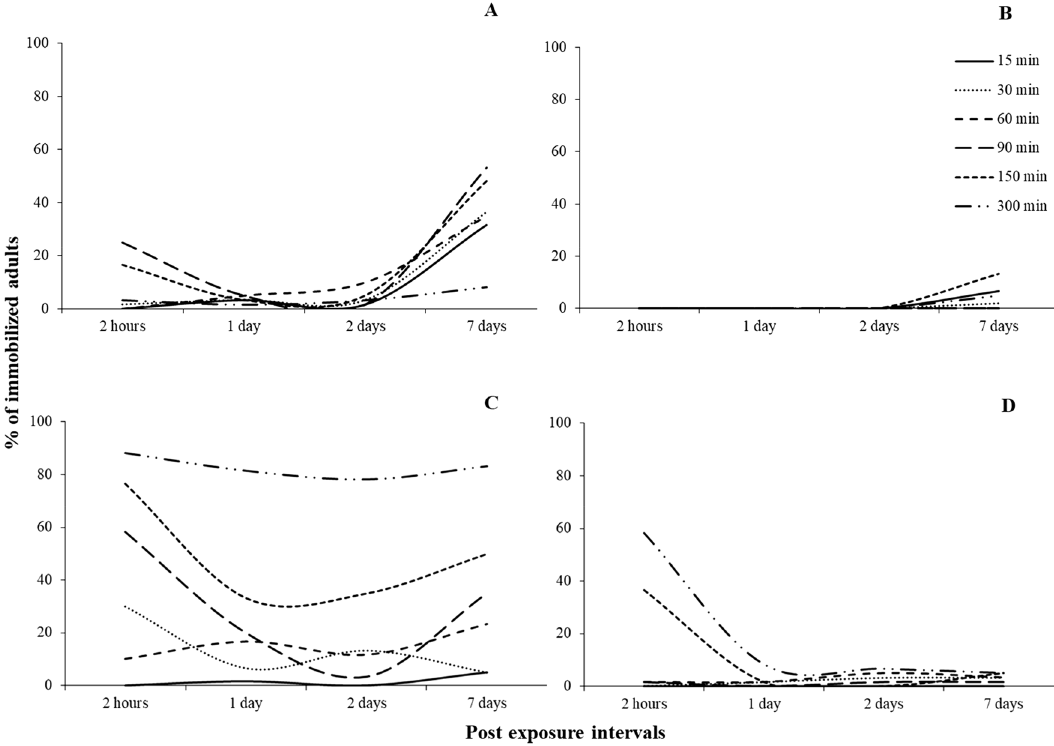
Figure 3. Percentage (%) of immobilized adults of resistant populations of R. dominica GA6 ( A ), S. oryzae 3TAB ( B ), O. surinamensis ASC11 ( C ) and T. castaneum BTS ( D ) for each exposure interval (15, 30, 60, 90, 150 and 300 min) after exposure to phosphine at 3000 ppm for different post exposure intervals (2 h, 1, 2 and 7 days). The equations for each exposure interval for each species are presented in Table